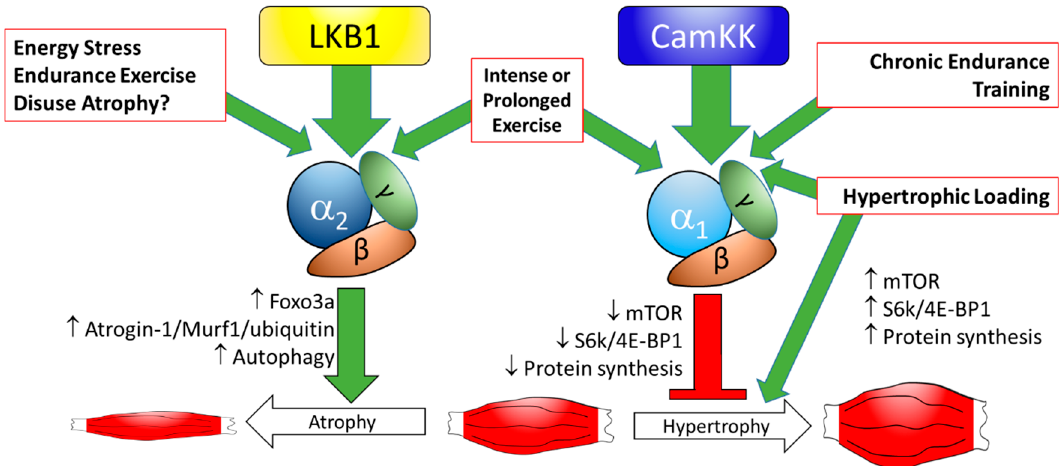
Figure 1. Proposed regulation of skeletal muscle size by 5’ ‐ adenosine monophosphate ‐ activated protein kinase (AMPK). Energy stress (decreased ATP/AMP ratio; as in moderately intensive exercise) predominantly activates AMPK α 2 via liver kinase B1 (LKB1), while AMPK α 1 is only activated by highly ‐ intense or prolonged exercise. Basal AMPK α 1 content and activity is also increased by long ‐ term endurance training, perhaps via Calcium/calmodulin ‐ dependent protein kinase (CamKK) action, or other AMPK kinases. AMPK α 2 stimulates catabolic processes by increasing Foxo3a, Atrogin ‐ 1 and MuRF ‐ 1 expression/activity and increasing autophagy, leading, under certain circumstance, to muscle atrophy, but has little effect on protein anabolism. AMPK α 1 impairs mTOR signaling, slows protein synthesis, and blocks hypertrophy. Hypertrophic loading (i.e., resistance exercise) stimulates mechanistic target of rapamycin (mTOR) signaling, protein synthesis, and hypertrophy, but also activates AMPK α 1 independent of LKB1 (perhaps via CamKK or other means), limiting the hypertrophic growth. ↑ : increase expression or activity; ↓ : decreased expression or activity.